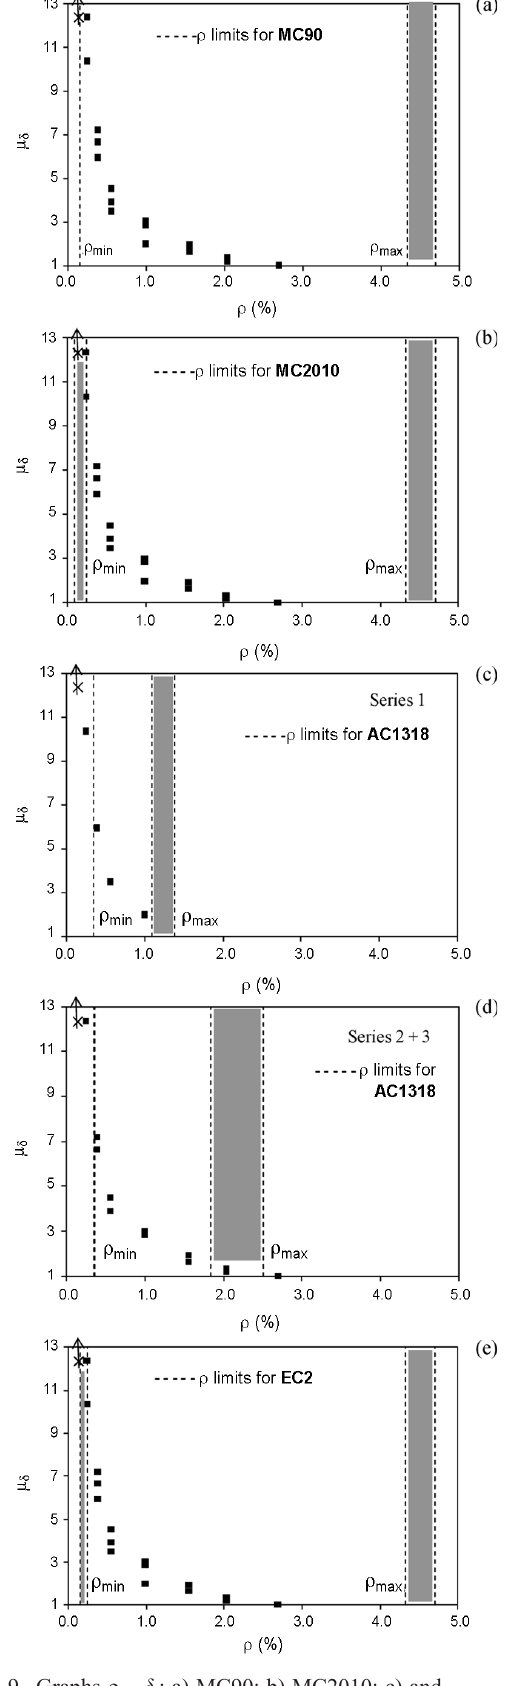
Fig. 9. Graphs ρ – δ i : a) MC90; b) MC2010; c) and d) ACI 318 (2011); e)